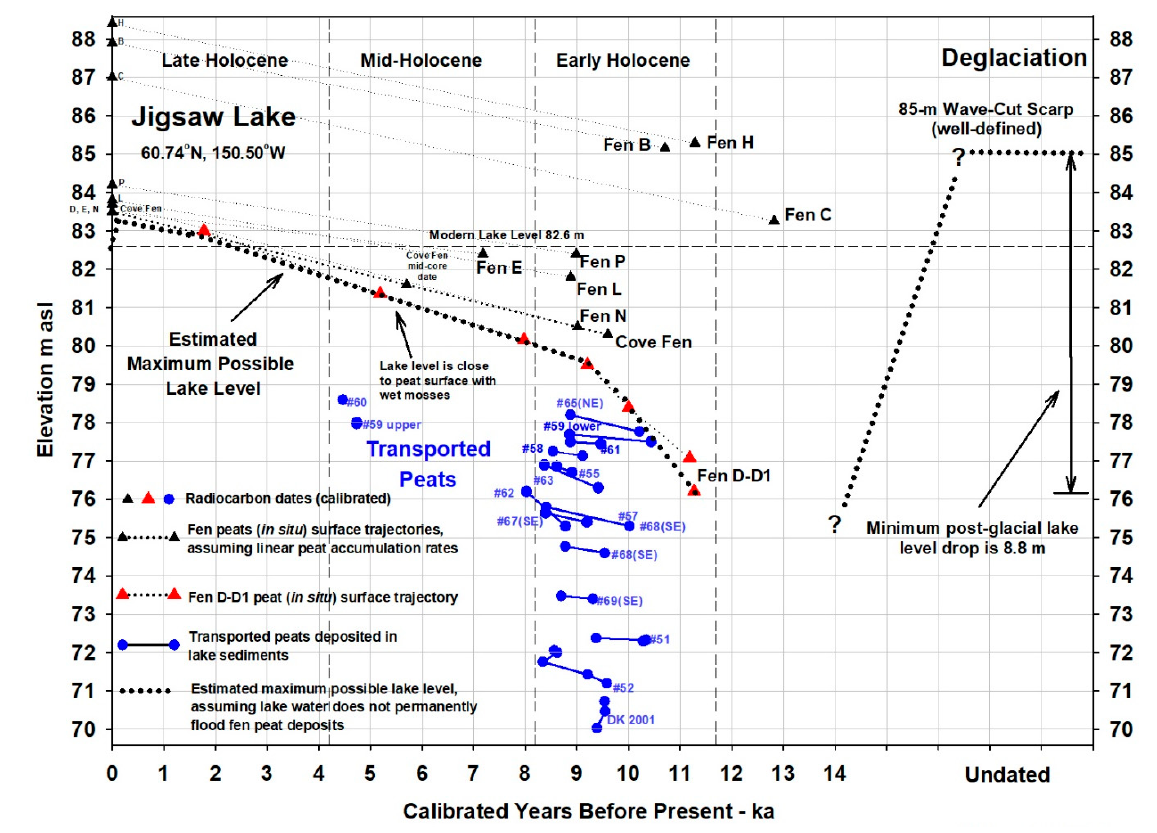
Figure 9. Jigsaw Lake hydrograph. The transported peats were recovered from sediment coring in the four basins of the lake; blue numbers are core IDs. Cores were taken in the NE basin, unless indicated otherwise in parentheses. Samples were AMS-dated from the bottom and top of each peat layer (blue dots). Red triangles are dated samples within the two Fen D-D1 cores. Black triangles are basal peat ages in satellite-fen peats within the Jigsaw Lake basin, as defined by the 85 m wave-cut scarp. Modern surface elevations of the fens are shown on the y-axis (x = 0 ka). Cores with only detrital material or gyttja are not shown. The dating of the 85 m wave-cut scarp and the subsequent decline of the lake level are hypothetical (see Section 4).